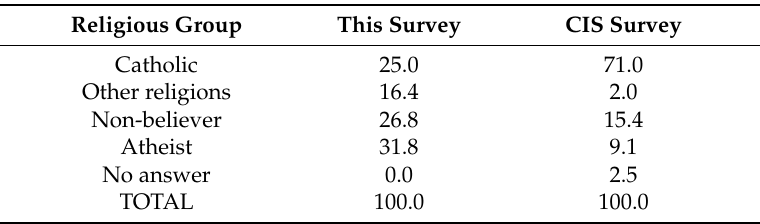
Table 1. Distribution of religious affiliations in our survey versus average values for Spanish society (CIS survey) (in %). Religious Group This Survey CIS